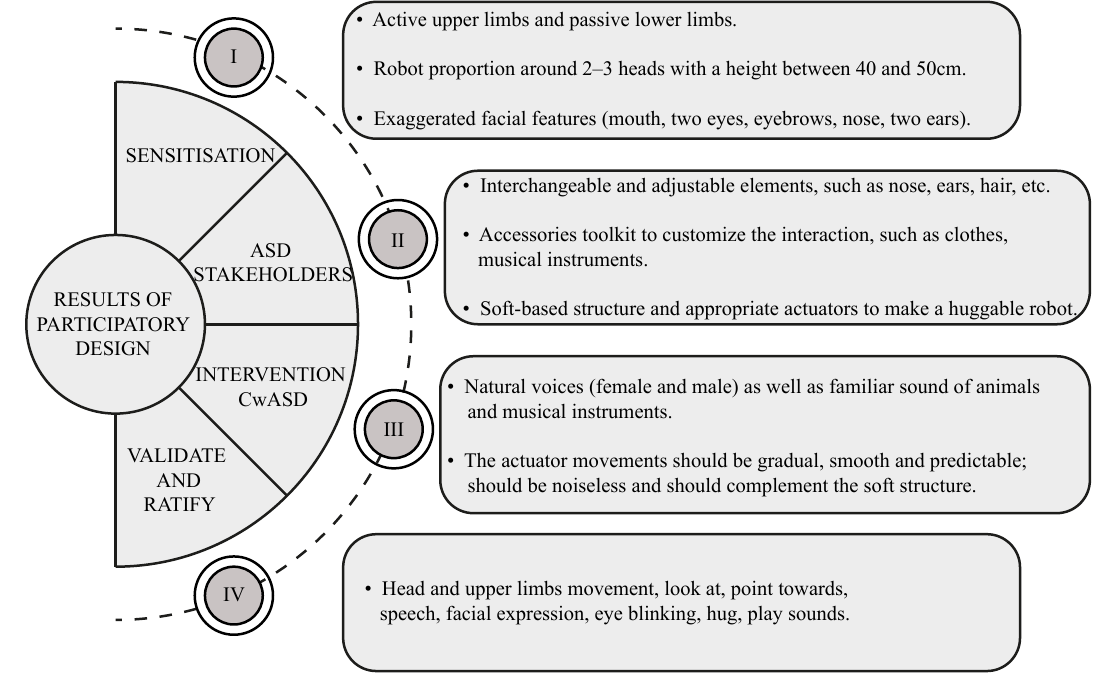
Figure 2. Guidelines for the robot design from the study based on the participatory design